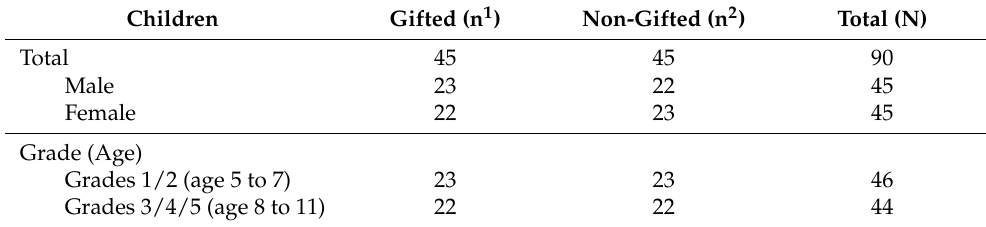
Table 2. Descriptive statistics for the smaller homogeneous sample used in the study. Children Gifted (n 1